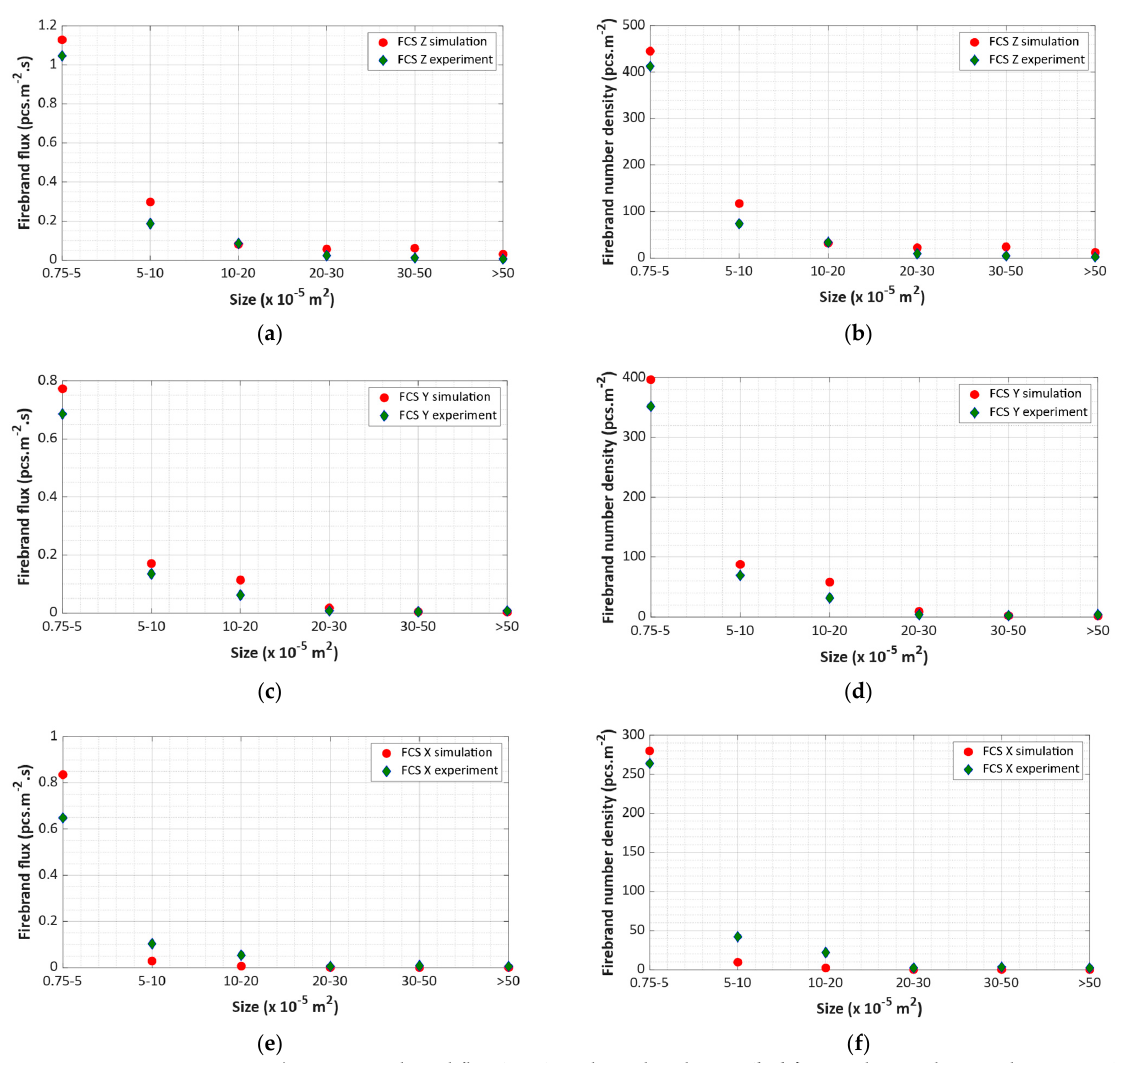
Figure 14. Firebrand flux ( a , c , e ), and number density ( b , d , f ) according to the size classes at Z, Y, X. Increasing the size of firebrands shows a decrement in both firebrand flux and number density at all the collection sites.